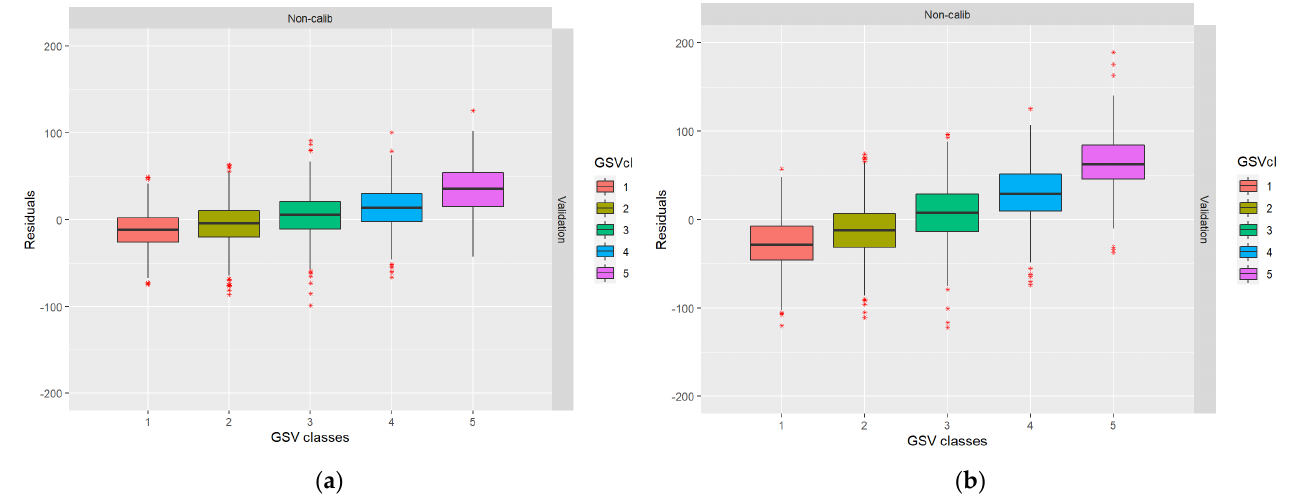
Figure 4. Boxplots showing the distribution of residuals across the range of true values: ( a ) ALS-based residuals; ( b ) DP-based residuals.